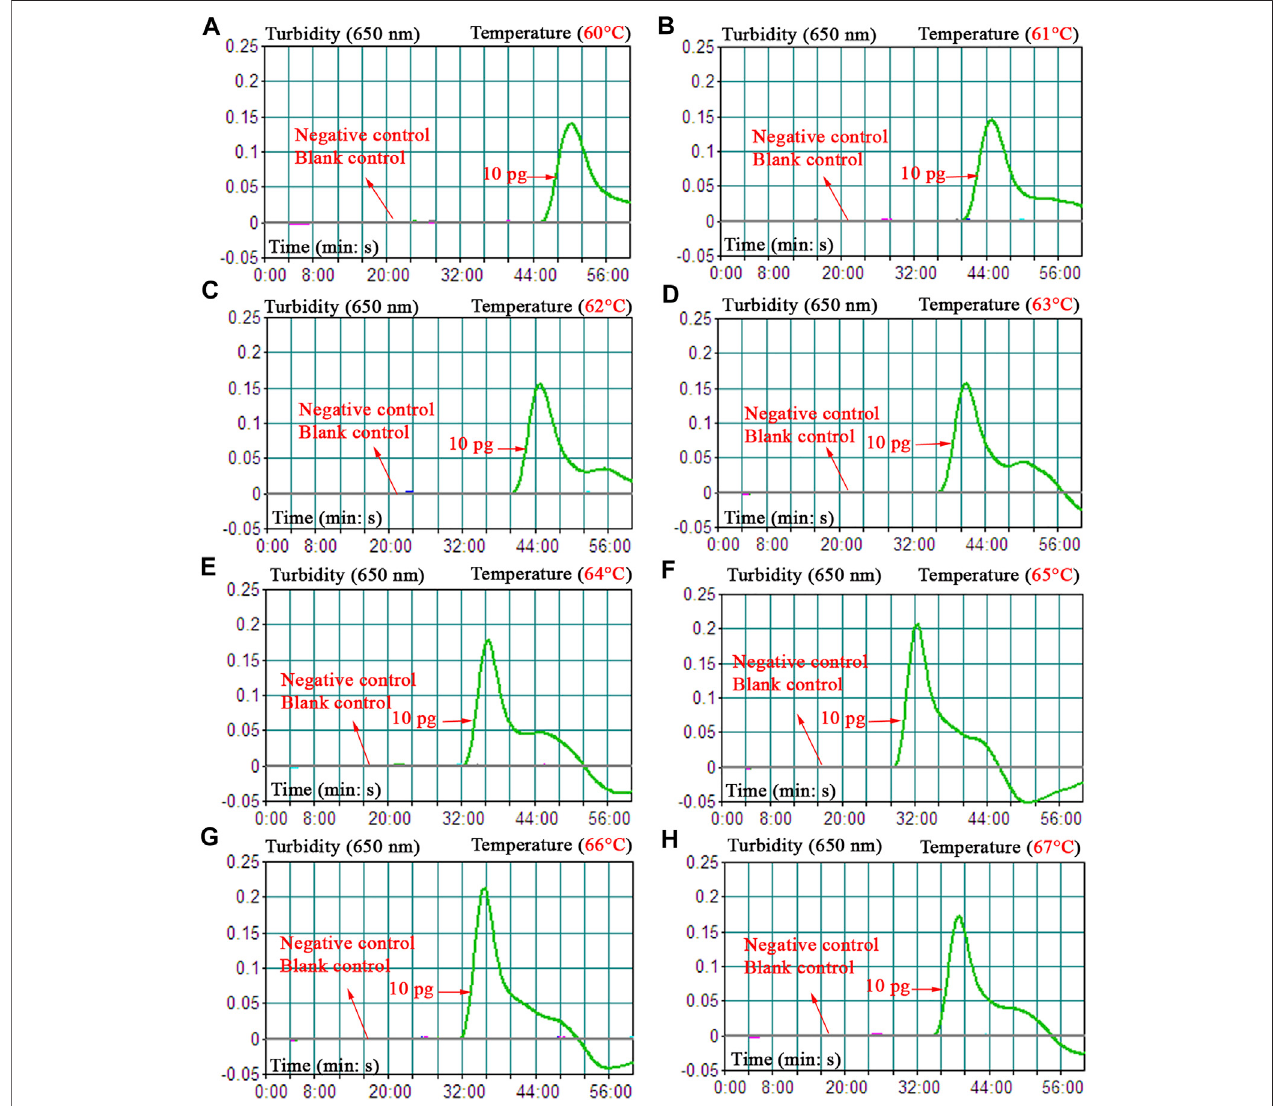
FIGURE 4 | Optimization of ampli fi cation temperature for the B. abortus -LAMP-LFIA assay. The standard B. abortus -LAMP assays were monitored by real-time turbidimetry,andthecorrespondinginformationwasmarkedinthedrawings.Thisthresholdvaluewas0.1,andaturbidity > 0.1wasjudgedasapositivereaction.Atotal of eight kinetic graphs (A – H) were generated at various temperatures (60 – 67 ° C, 1 ° C intervals) with template DNA at the level of 10 pg/ μ l. The drawings from (E – G) showed higher ampli fi cation ef fi ciency. LAMP, loop-mediated isothermal ampli fi cation; LFIA, lateral fl ow immunoassay biosensor; TL, test line; CL, control line; ddH 2 O, double distilled water; BC, blank